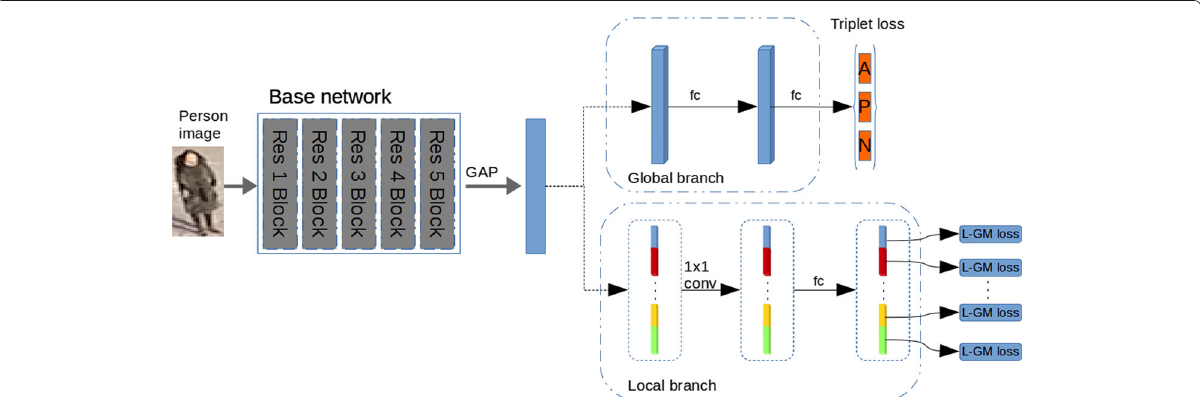
Fig. 3 The proposed framework. We feed the input image to a base network (ResNet-50) and extract the global feature vector after global average pooling (GAP). The global branch contains two fully connected layers, which transform the feature vector into 128-d embedding. The embedding is feed to the triplet loss. The local branch divides the feature vector into N c channel groups. Each channel group is feed to the shared 1 × 1 convolutional layer. Then, each feature vector is feed to its own fully connected layer. The output of the fully connected layer is feed to the L-GM loss function